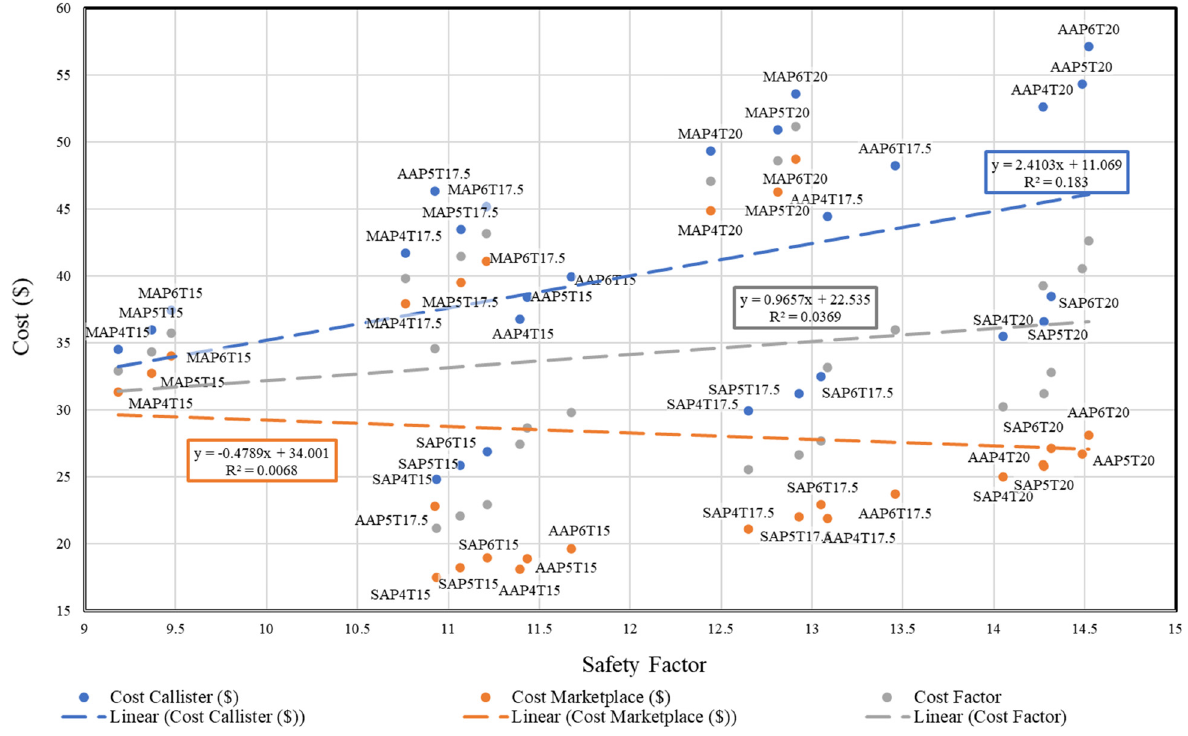
Figure 14: Impact of rim wheel cost on the safety factor ( all costs are in US$ )